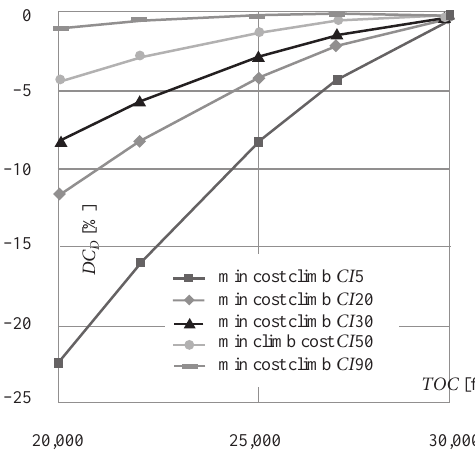
Fig. 12. The change of Δ C D with TOC , for minimum cost climb technique, m c 1 = 41,000